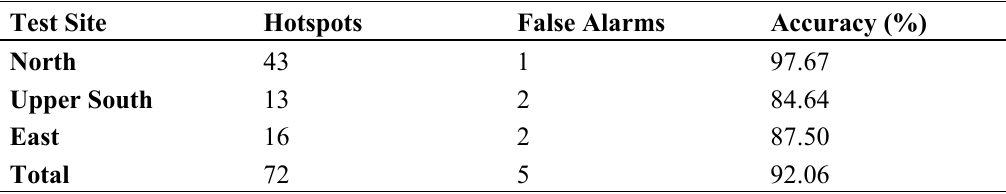
Table 5. Test site validation